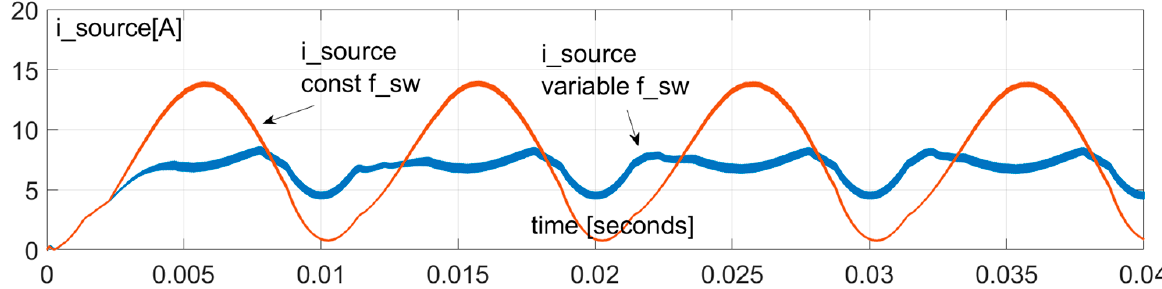
Figure 17. The DC source current in the case of operation of the AIVB with constant switching frequency and variable frequency according to the reference presented in Figure 12.